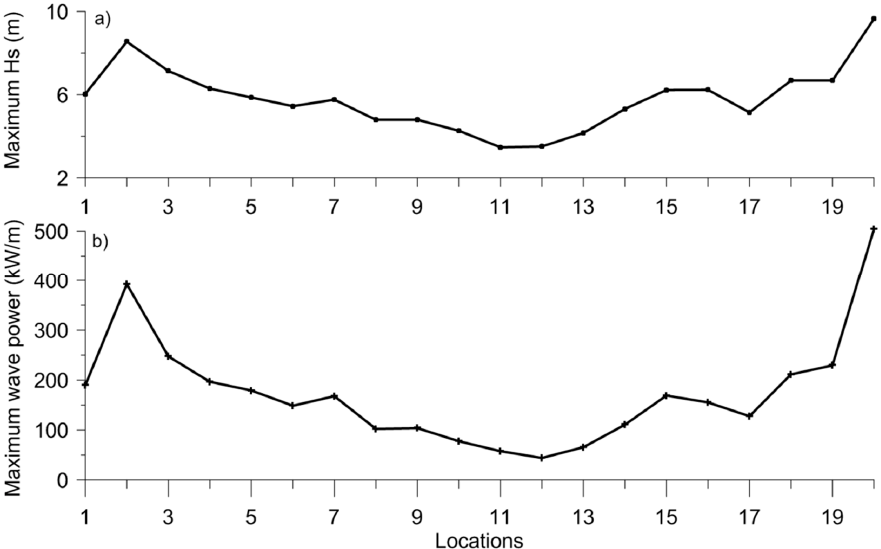
Figure 11 . ( a ) Maximum of the significant wave height at different locations and ( b ) the Figure 11. ( a ) Maximum of the significant wave height at di ff erent locations and ( b ) the corresponding corresponding maximum wave power. maximum wave